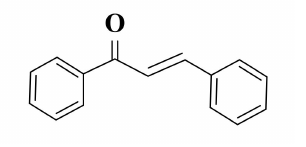
Figure 2. General structure of